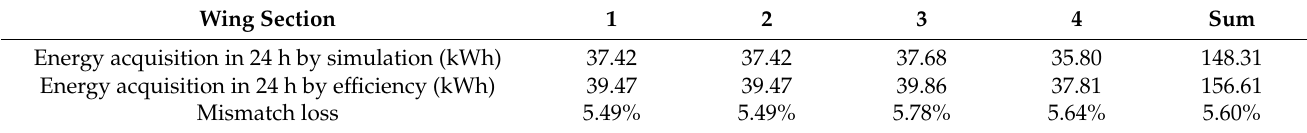
Figure 7. Output power of different wing sections over a period of 24 h. ( a ) Output power of wing section 3. ( b ) Output power of wing section 4. Table 2. Total energies obtained in a